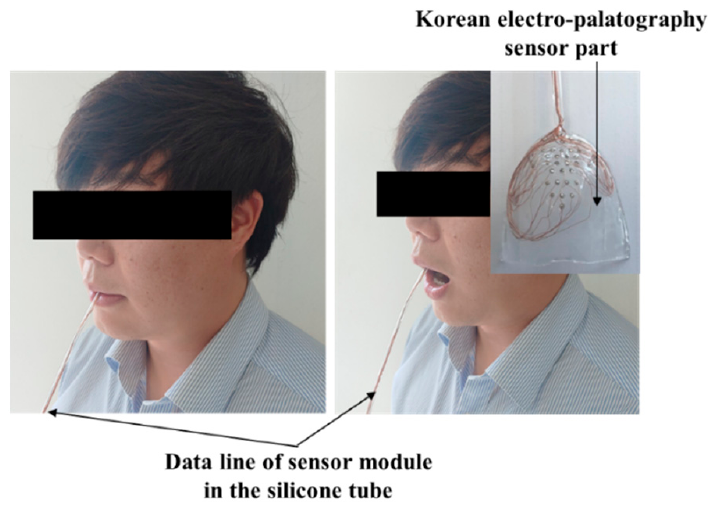
Figure 8. Experimental setup for the evaluation of the electropalatography system in the healthy control group (man, aged 35 years old).